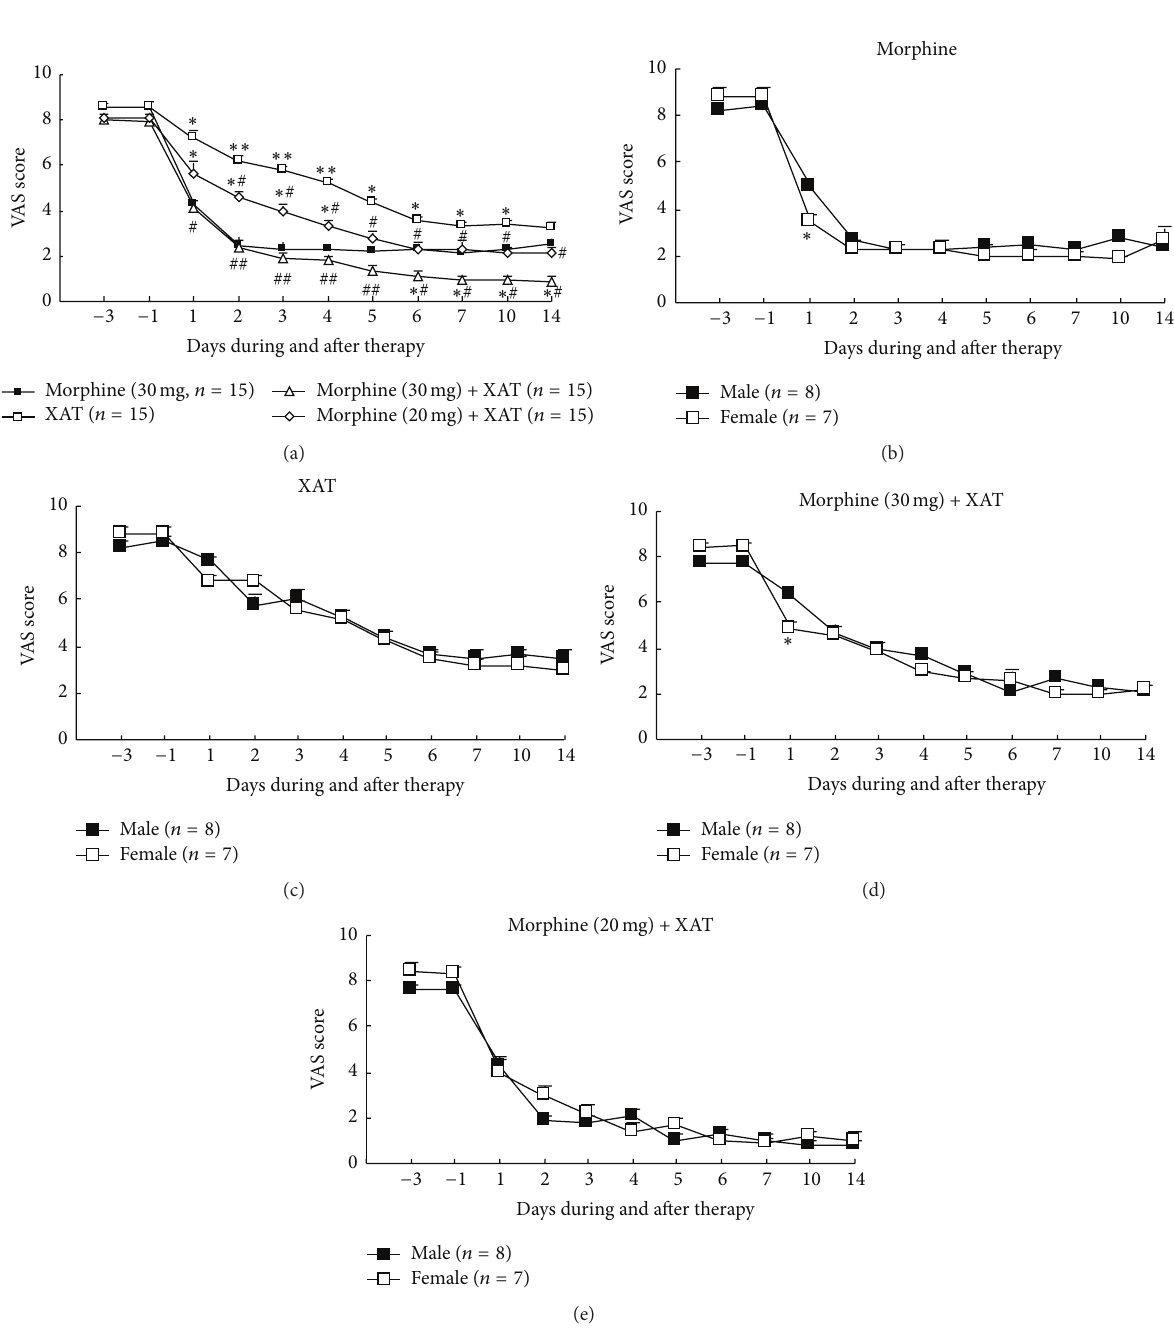
Figure 1: Repetitive oral administration of XAT reduced cancer pain and facilitated analgesic effect of morphine on patients with bone cancer pain. VAS test was used for evaluating the pain intensity. (a) Comparison of analgesic effects (VAS scores) of morphine, XAT, and combination of XAT and morphine. (b-c) Comparison of analgesic effects of morphine, XAT, and combination of XAT and morphine between males and females. Data are expressed as mean ± SEM. Number of patients in each group is indicated in the parentheses. Note that all of the patients indicated in (b-c) were from the same male and female patients’ group in (a). The treatments in each group were applied daily for 7 consecutive days during days 0–6. Two-way ANOVA. ∗ 𝑃 < 0.05 and ∗∗ 𝑃 < 0.01 versus morphine (a) or versus male (b, d). # 𝑃 < 0.05 and ## 𝑃 < 0.01 versus XAT